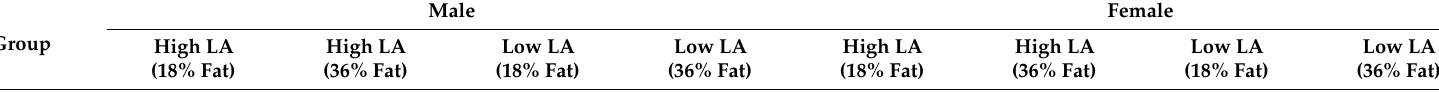
Table 3. O ff spring lipogenic gene expression in male and female o ff spring at 4 weeks of